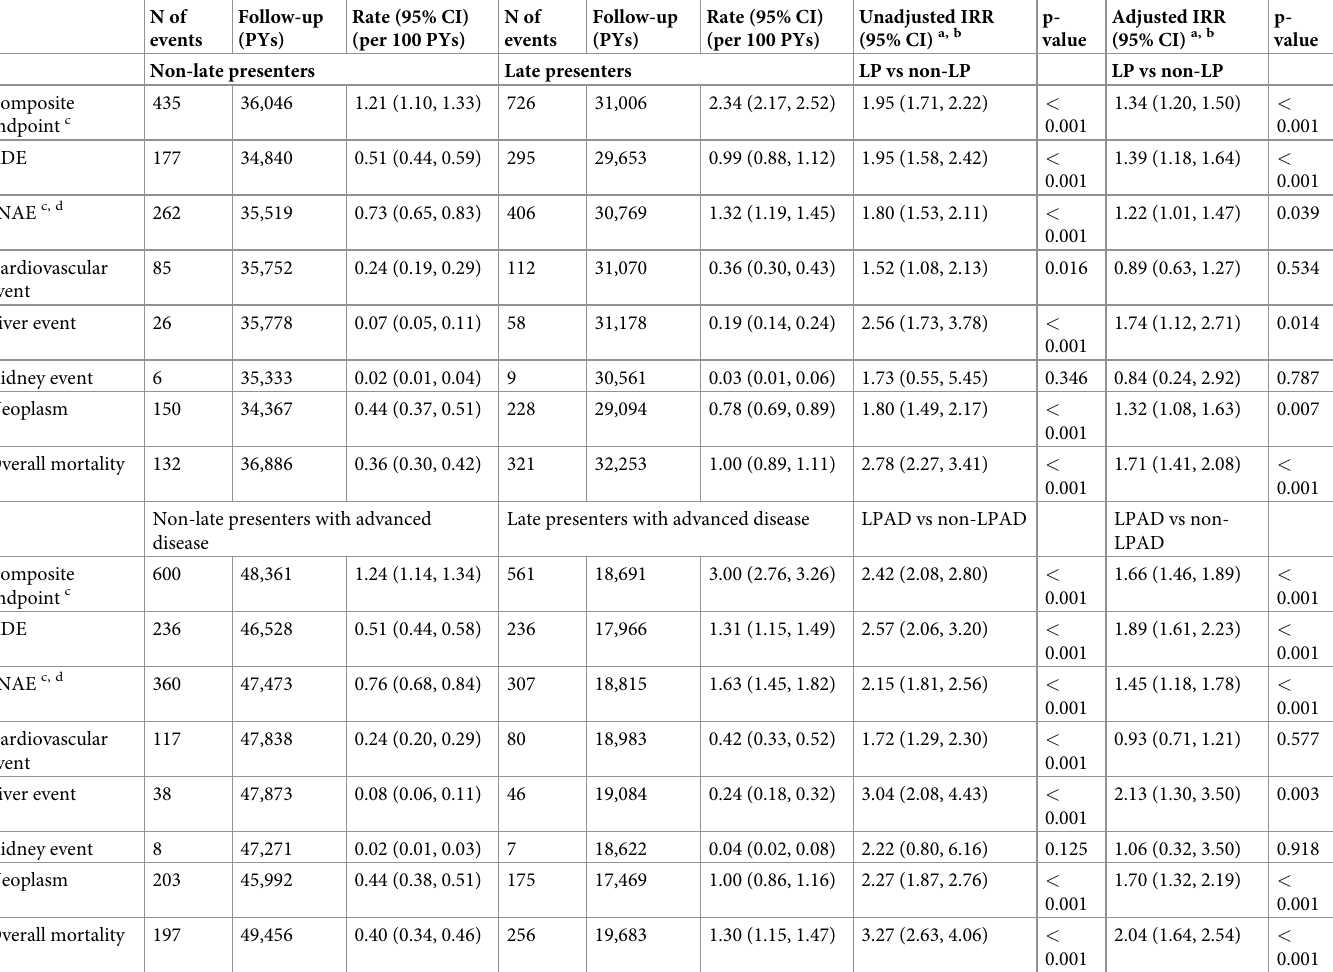
Table 3. Impact of late presentation and late presentation with advanced disease on the composite endpoint, first ADE, first SNAE and overall mortality, Spain, 2004–2018, (N = 13,031 and 69,142 persons-year of